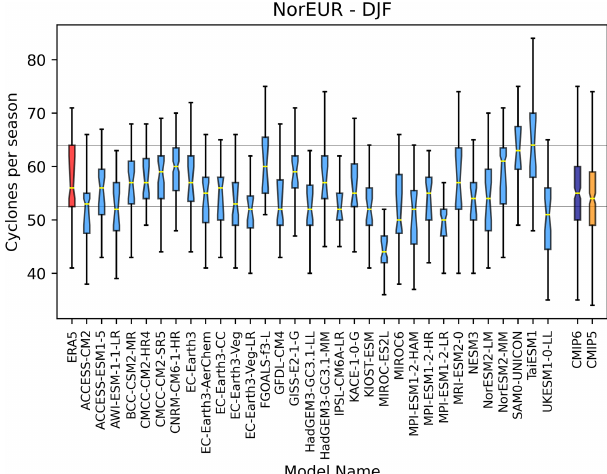
Figure A7. Boxplots of cyclone numbers per DJF season for the NEU region (coordinates). Boxes are shown for ERA5 (red), 32 CMIP6 models (light blue), and the CMIP6 (purple) and CMIP5 model ensembles (orange). Boxes extend to the 25th and 75th per- centiles of the distributions, with whiskers extending to 1.5 times the interquartile range. Horizonal yellow lines indicate the medians. Notches around the medians show its uncertainty based on 10000 random resamples. Horizontal grey lines indicate the ERA5 25th and 75th